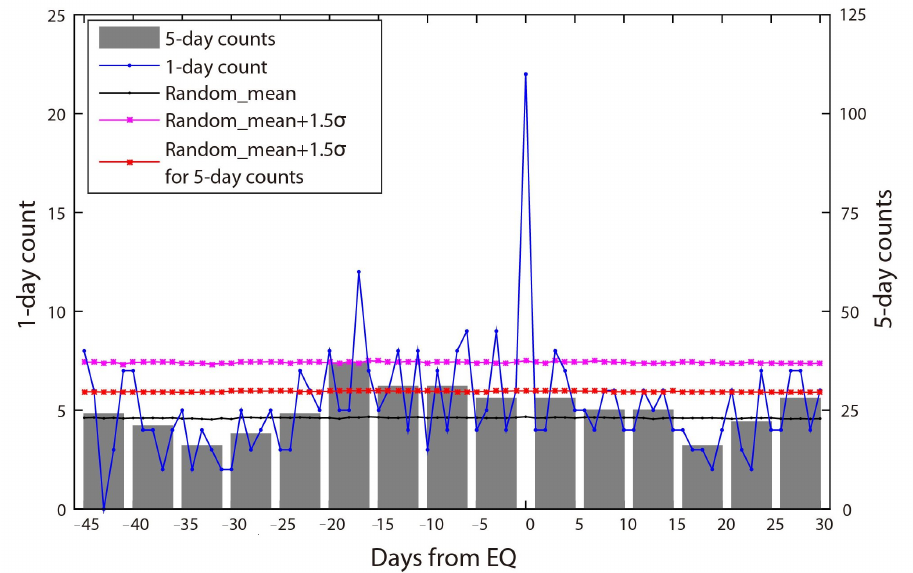
Figure 6. The Superposed Epoch Analysis (SEA) results of strain network anomalies. The blue, the black, and the red lines indicate the counts of 1-day count, random_mean, and random_mean+1.5 σ , respec- tively. The grey bars and the pink line demonstrate 5-day counts and corresponding random_mean+1.5 σ . The “0 day” indicates the day when E s ≥ 10 7